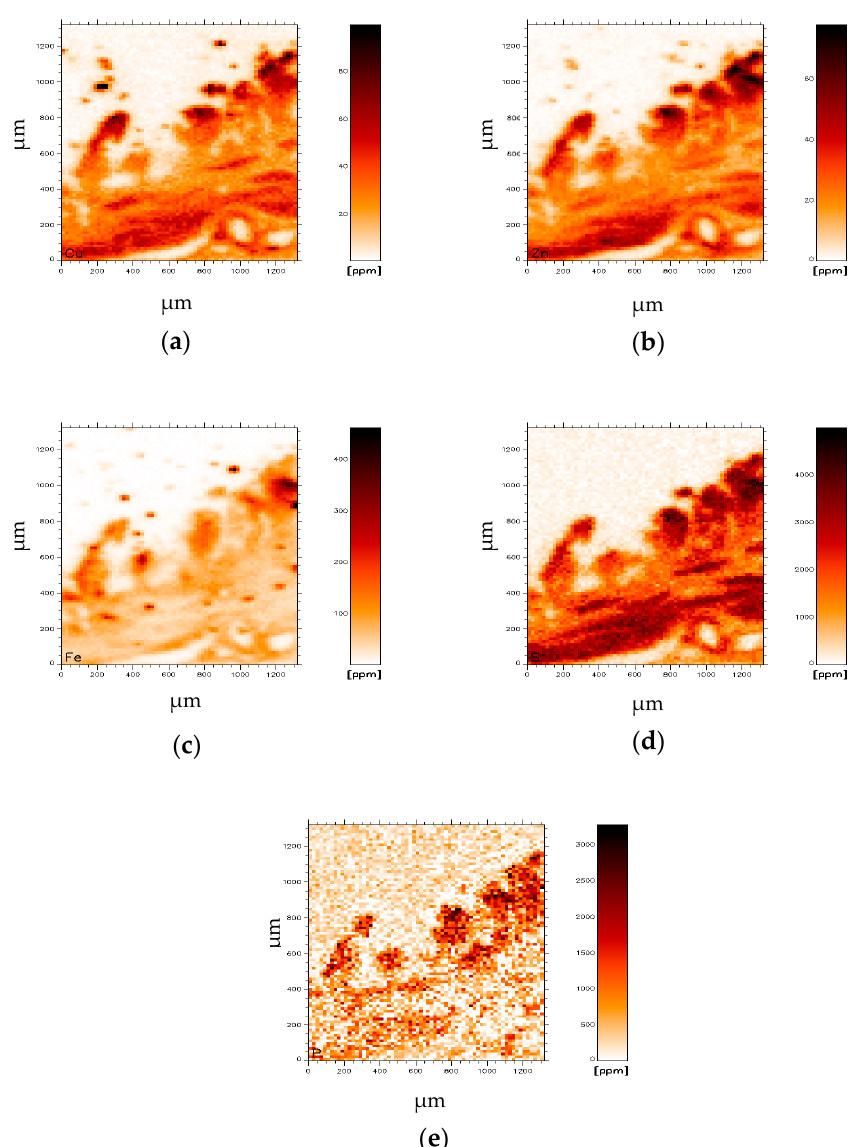
Figure 4. Distribution of elements in a WD gallbladder. ( a ) copper (Cu), ( b ) zinc (Zn), ( c ) iron (Fe), ( d ) sulphur (S) and ( e ) phosphorus (P).